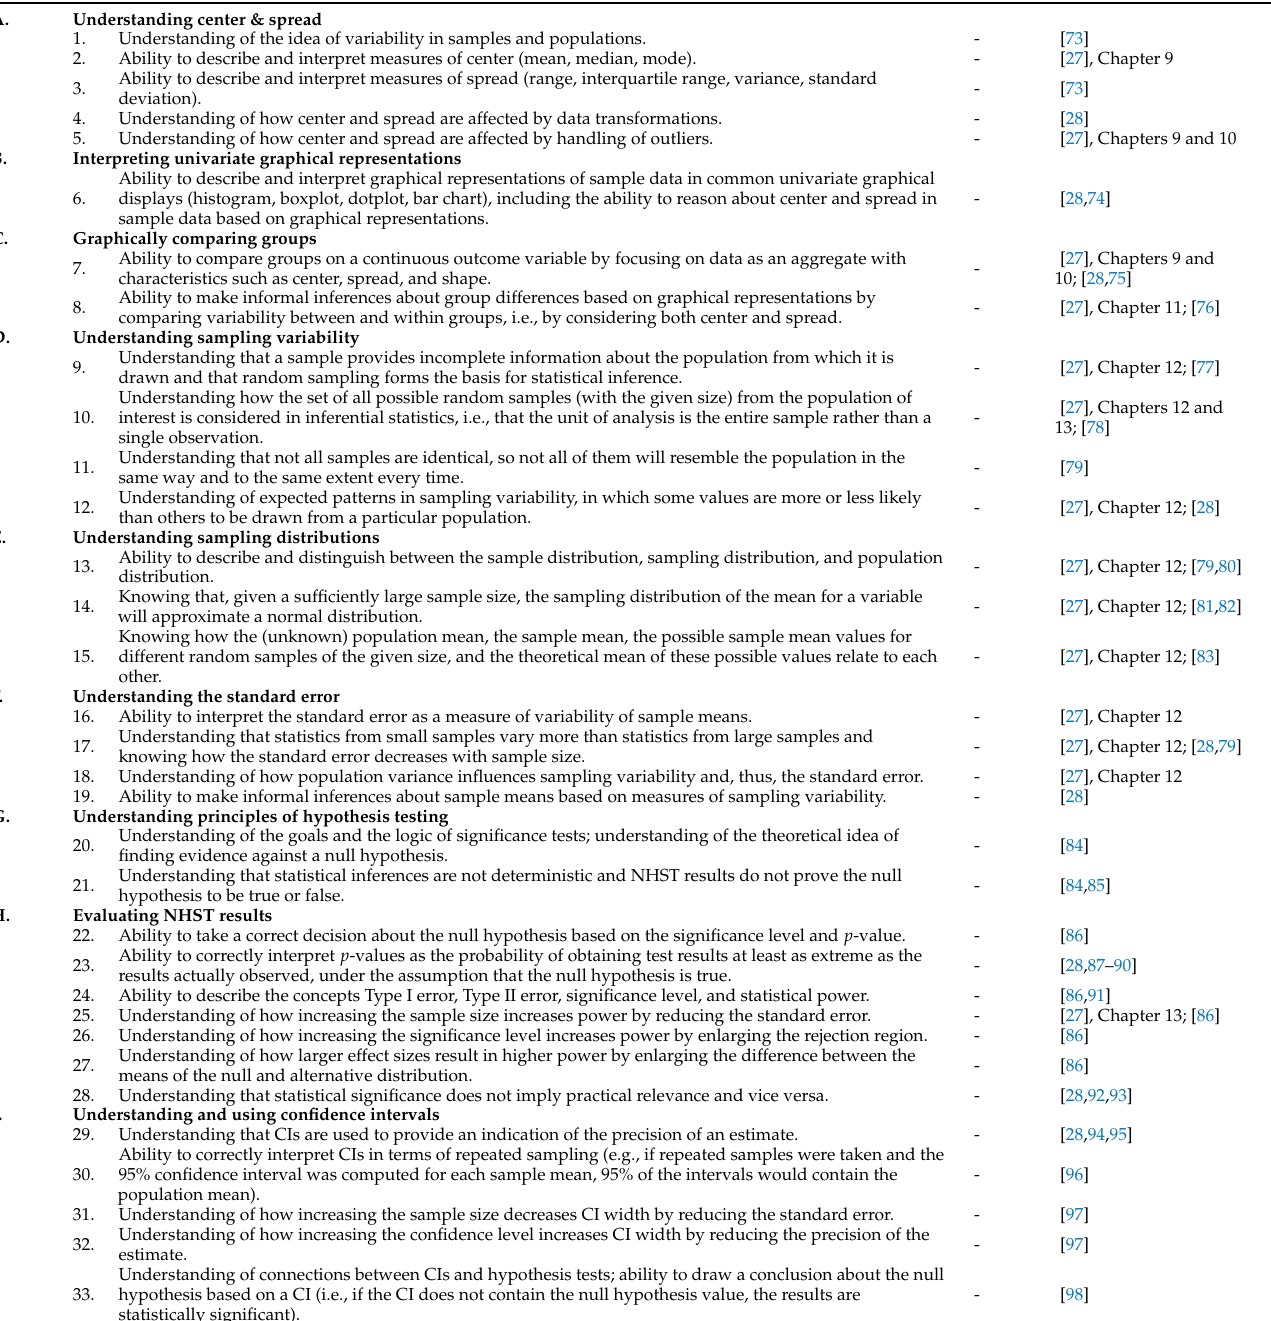
Table A1. Identified attributes and learning objectives with references showing their